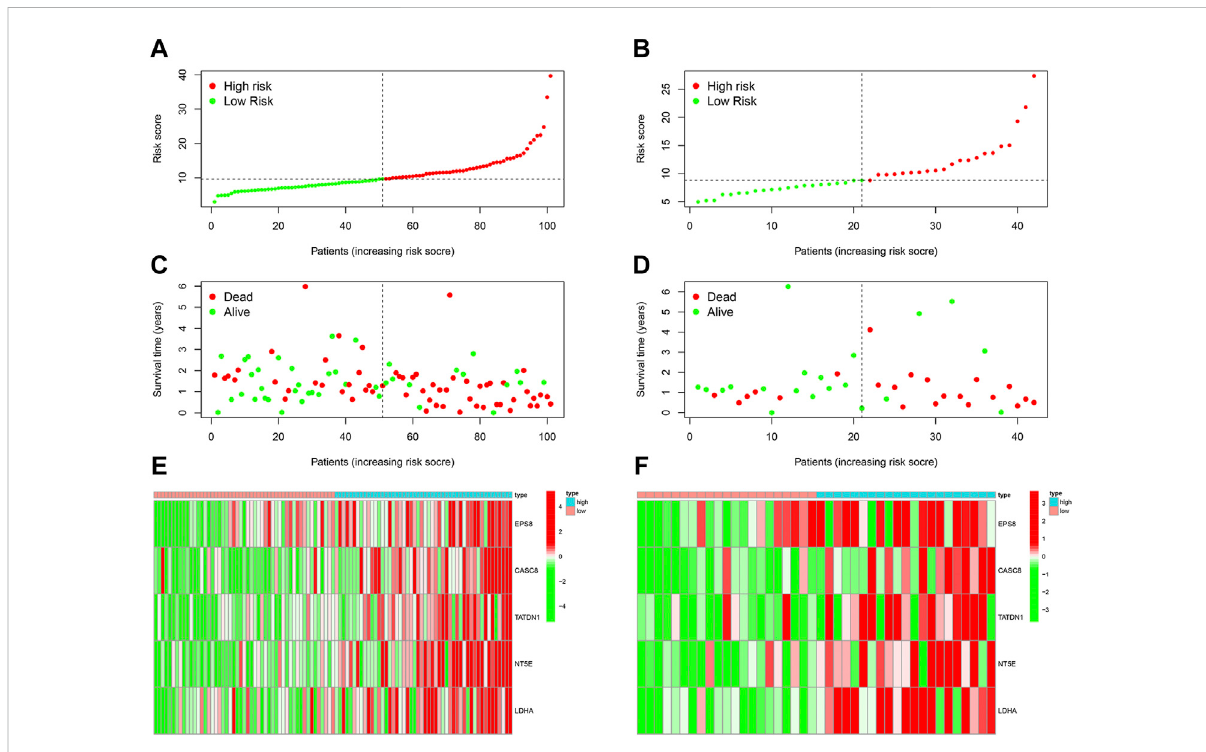
FIGURE 3 EvaluationofCDRG-based prognosticmodel. (A,B) Weanalyzedthedistributionofgeneexpressionandpatientsurvivalinthemodelsbetween thehigh — andlow-riskgroupsintrainingandtestcohorts. (C,D) Wefoundthatwiththeincreaseinriskvalue,theproportionofBCpatientswhodied increased. (E,F) Moreover, we found that genes EPS8, CASC8, TATDN1, NT5E, and LDHA were highly expressed in the low-risk